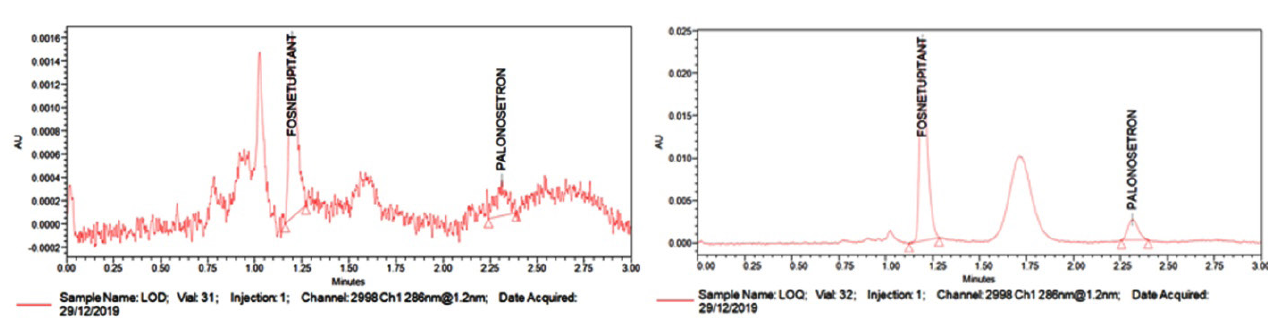
FIGURE 3 - LOD and LOQ